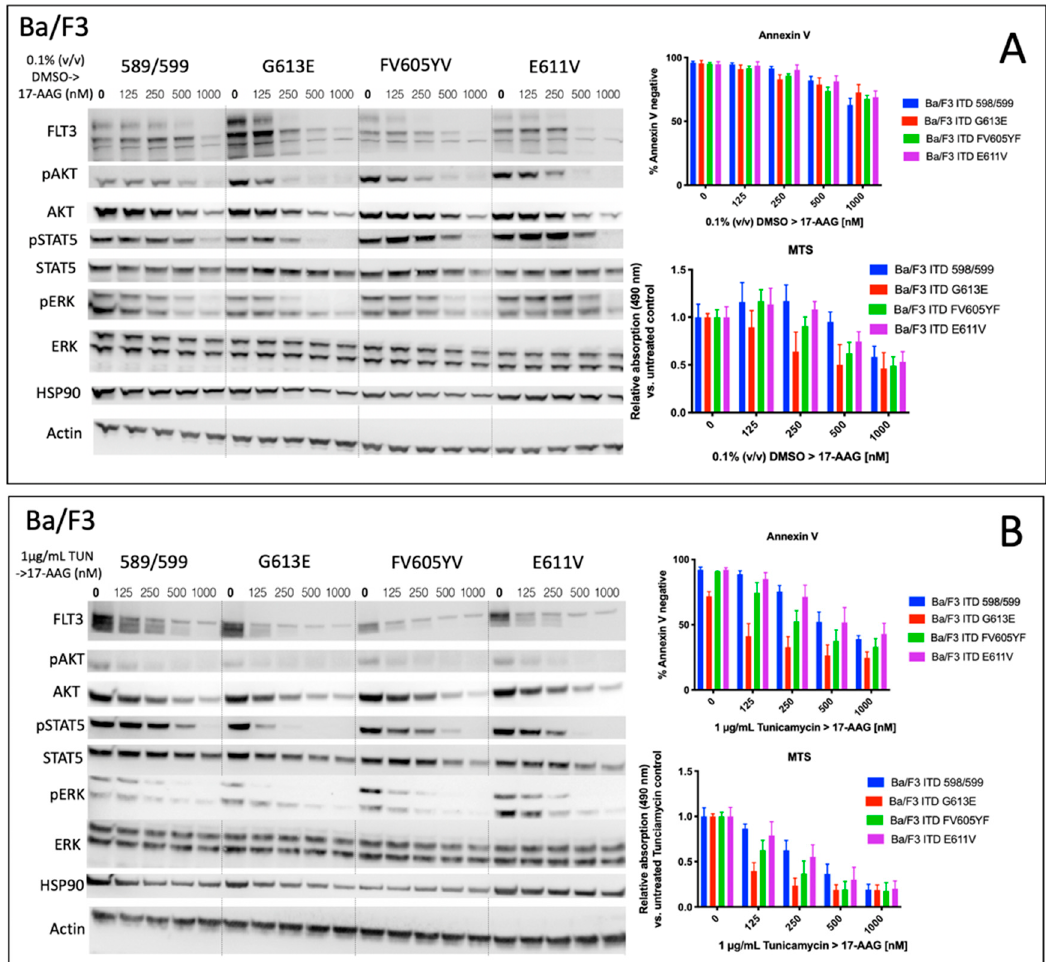
Figure 1. Signal transduction, metabolic activity, and apoptosis after treatment of Ba/F3 cell lines expressing four distinct FLT3-ITD variants with 17-AAG after pre-incubation with tunicamycin. Immunoblotting analysis of signaling pathways (left) after sequential incubation of four Ba/F3 cell lines stably expressing different FLT3-ITD variants with 1 μ g/mL tunicamycin and 17-AAG. ( A ) Ba/F3 cells were incubated with 0.1% ( v / v ) DMSO for 24 h followed by treatment with 17-AAG at the indicated concentrations for 24 h. ( B ) the incubation was started with 1 μ g/mL tunicamycin for 24 h prior to treatment with 17-AAG at indicated concentrations for a further 24 h. Whole cell protein lysates were subjected to SDS-PAGE and immunoblotting to assess the expression and phosphorylation status of the signaling proteins. For loading control, the levels of beta-Actin were detected. Representative blots of the three independent experiments are shown. Corresponding assays indicating metabolic activity (MTS) and apoptosis (Annexin V) are illustrated in the right section of all Ba/F3 FLT3-ITD cell lines. The data for MTS assays are shown as relative absorption compared to untreated controls. Apoptosis is demonstrated by Annexin V-negative cells indicating viable, non-apoptotic Ba/F3 cells. Graphs are shown as the mean + SD that were obtained from three independent experiments. Statistical significance between each Ba/F3 cell lines comparing DMSO vs. tunicamycin group was calculated using paired t -tests. p values of Student’s t -test, raw data, as well as IC 50 values are shown in Table S1 in the Supplement.